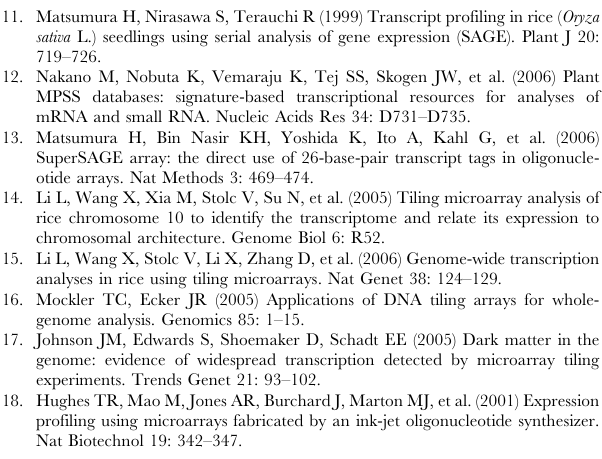
Figure S5 Transcriptional verification of non-exonic TARs. (a) Re-array detection of different groups of TARs. Detection rate was calculated as the percentage of TARs detected in at least one of the 10 assayed tissue types by the re-array. All, all non-exonic TARs; + Hit, TARs match with rice Unigenes; -Hit, TARs do not match with Unigenes. (b) RT-PCR analysis of selected non-exonic TARs. Pie charts indicate the percentage of TARs generated